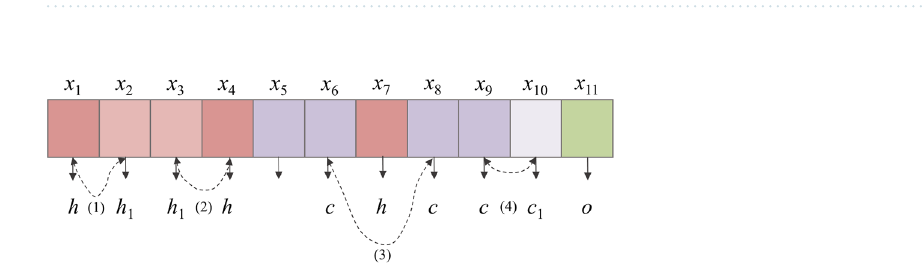
Figure 1. Network structure of GloVe and the co-occurrence matrix.